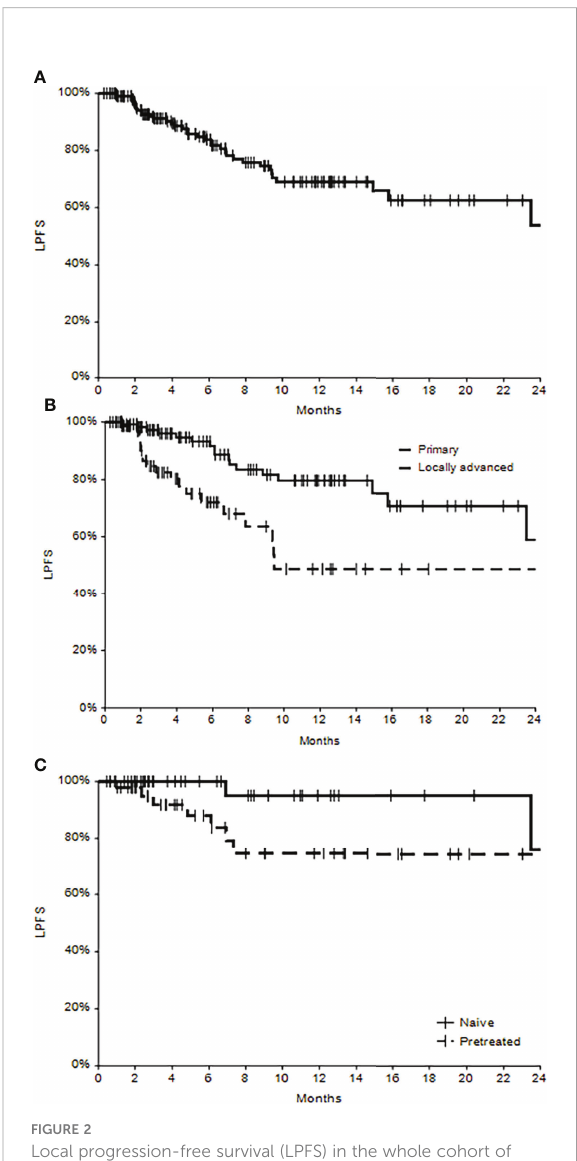
FIGURE 2 Local progression-free survival (LPFS) in the whole cohort of patients (A) , in subgroups of primary and locally advanced cSCC (B) and in subgroups of naïve and pretreated patients (C)